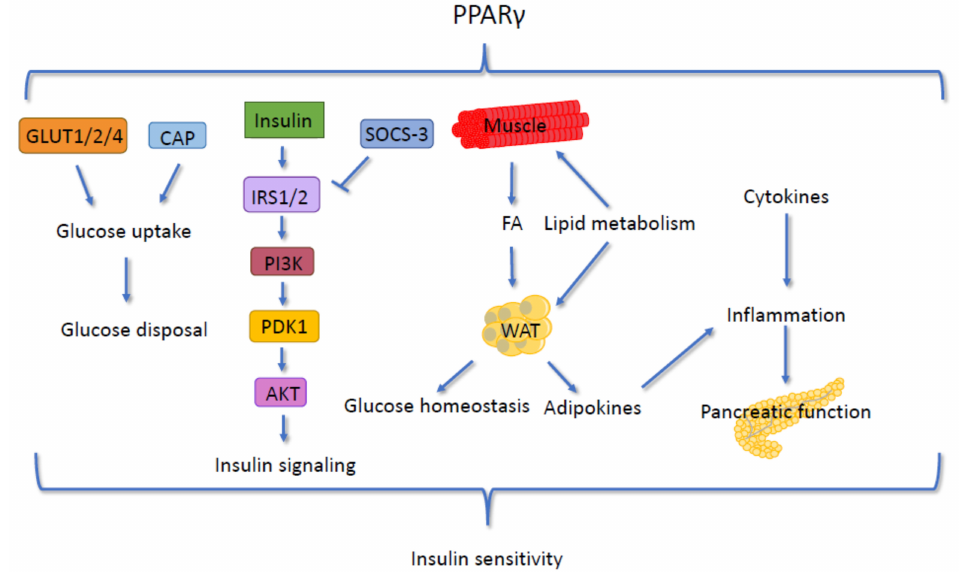
Figure 5. Pathways in which PPAR γ activity leads to increased insulin sensitivity. PPAR γ a ff ects insulin sensitivity by managing glucose uptake and disposal, enhancing insulin signaling, and maintaining functioning WAT and